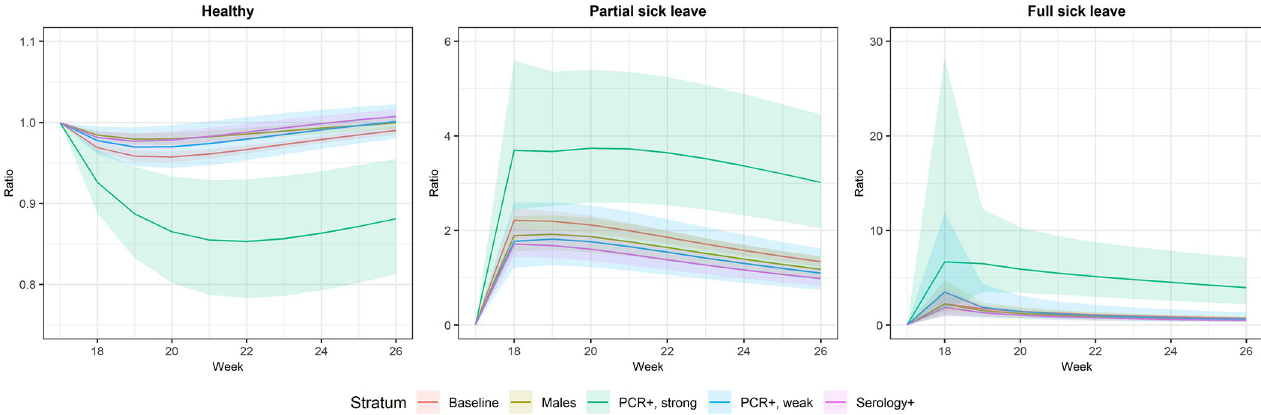
Fig 3. Ratios of longer-term standardized transition probabilities comparing to referent period by calendar week. a. The referent period is from week 28 to week 34. b. Longer-term standardized transition probabilities refer to sum of standardized transition probabilities.